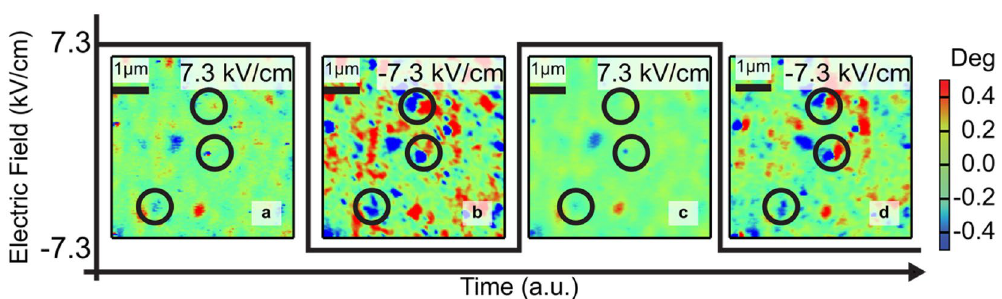
Figure 5. Local Memory of Directionality. Magnetic force microscopy of the FeRh layer at 60 °C under a DC electric field of ± 7.3 kV/cm is applied. Images are labeled sequentially with their corresponding electric field. The magnetic response in ( a ) and ( c ) are drastically diminished, when compared with the same region in ( b ) and ( d ). The local magnetic memory effect is observed here as the local magnetization is reversibly modified with electric